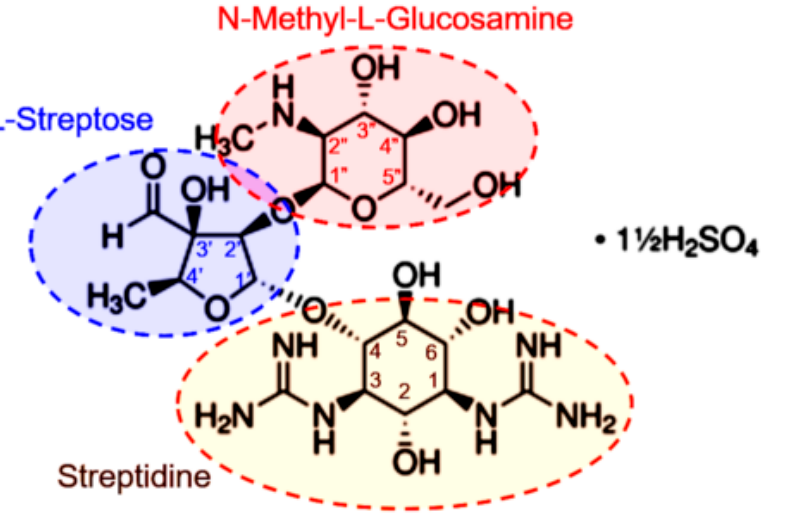
Figure 1. Chemical structure of STR sulfate.